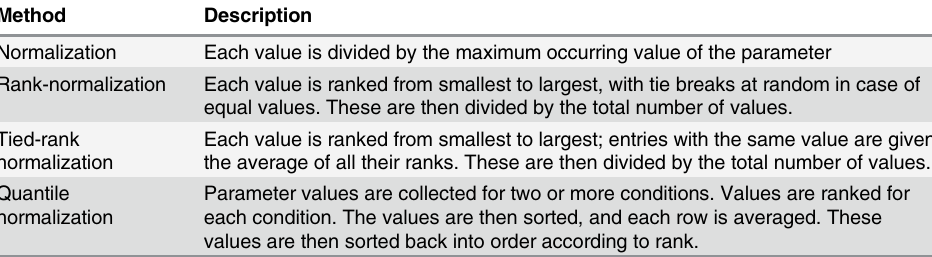
Table 2. Methods of network parameter